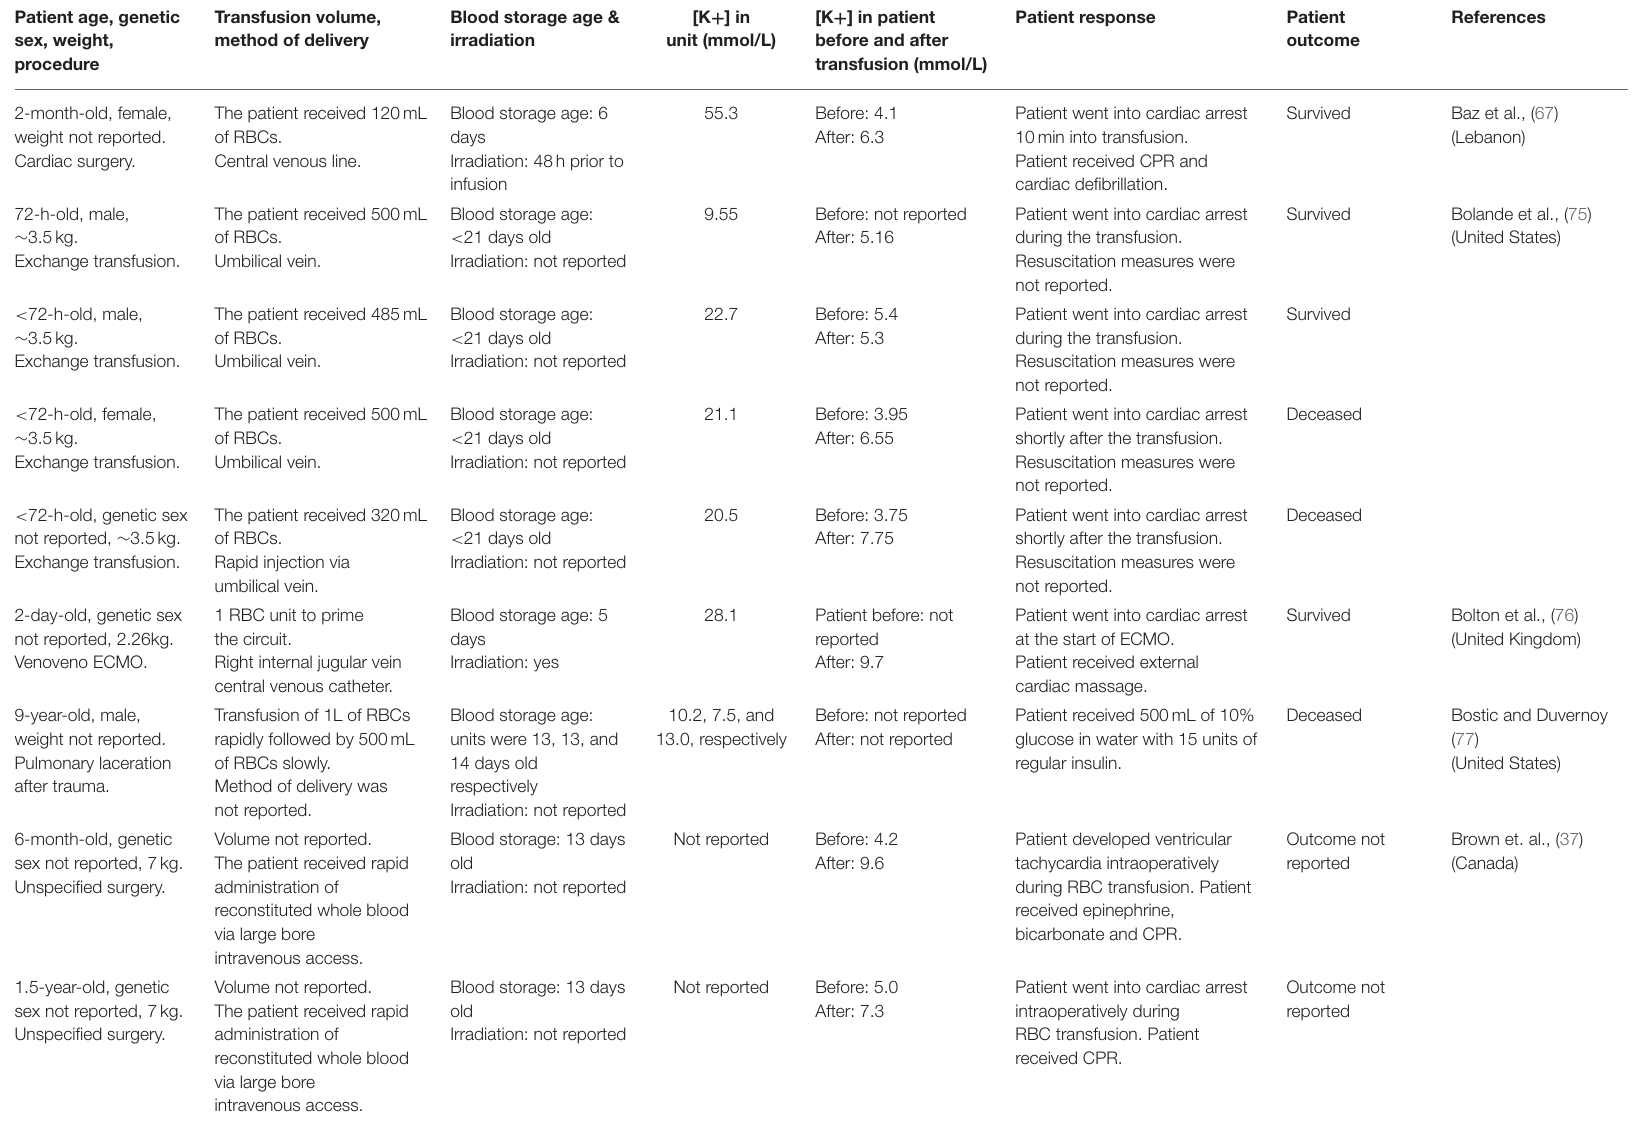
TABLE 1 | Pediatric cases of transfusion-associated hyperkalemia cardiac